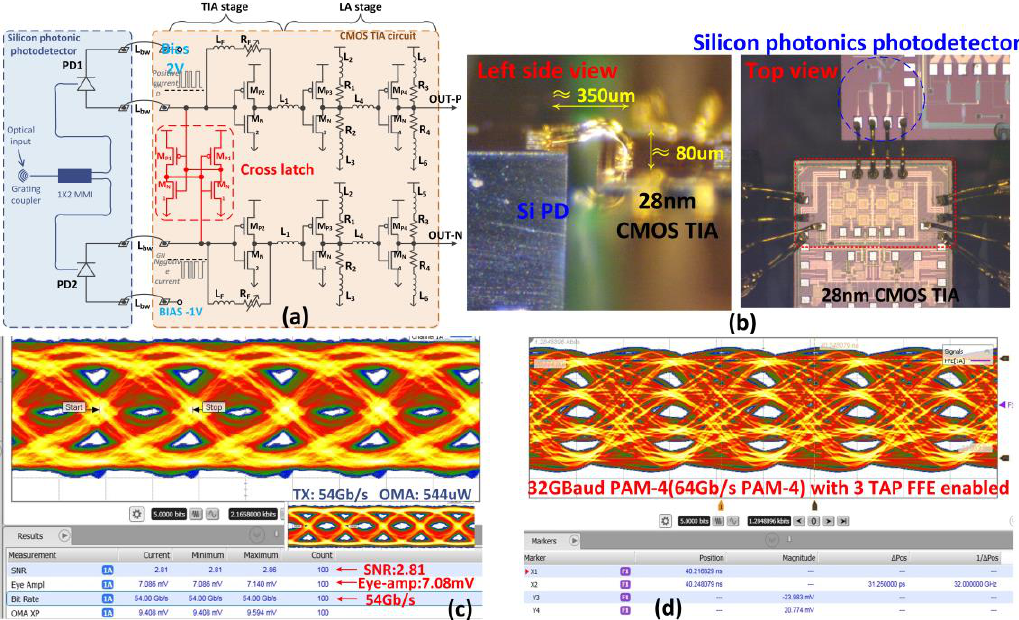
Figure 18. The integrated Si photonics receiver. ( a ) Circuit diagram of the balanced PD integrated with a CMOS transimpedance amplifier (TIA), ( b ) microscope image of the Si photonics receiver, ( c ) measured results at 40 Gb / s OOK and ( d ) measured results at 64 Gb / s PAM-4 (reprinted from [151], The Optical Society, 2020).